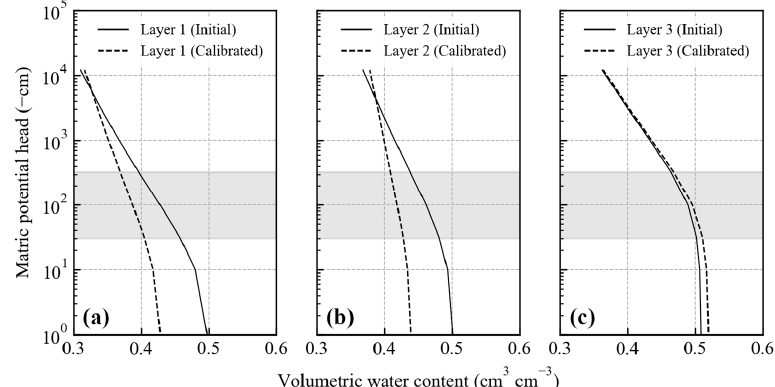
Figure 5. The analytical soil water retention curves generated by initial and calibrated Mualem–van Genuchten parameters. ( a – c ) Results for layers 1, 2, and 3, respectively. The grey area represents the zero-water-stress zone; drought or wet stresses occur outside this area. In the scenario condition, layers 1 and 2 used the calibrated soil water retention curve of layer 1.